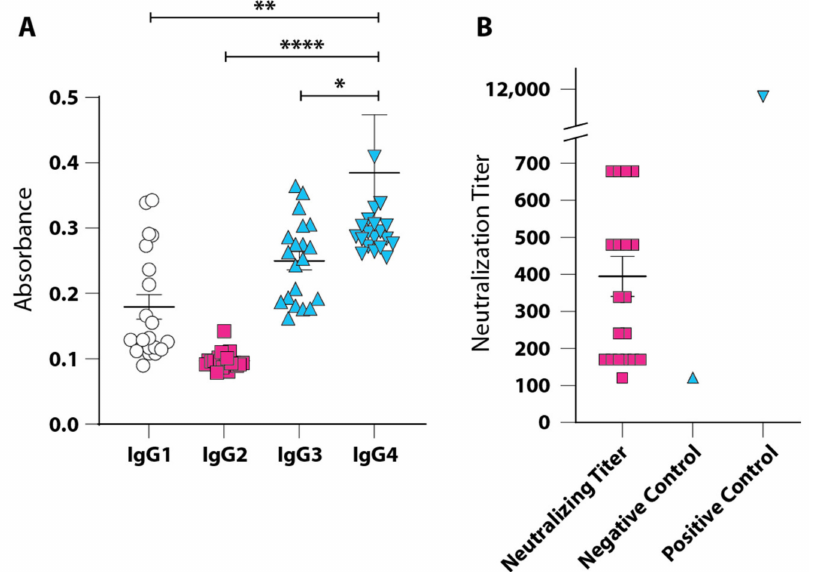
Figure 2. IgG isotypes in serum from unvaccinated, convalescent COVID-19 patients. ( A ) Evaluation of the sera for IgG isotypes of RBD-directed antibodies in 20 convalescent patients. Data are presented as ELISA absorbance values due to limited sample volume. ( B ) Neutralization titers in the serum samples ranged from 170 to 960 (GMT = 328). Serum from a naïve donor who had not been vaccinated or infected served as the negative control and serum from a donor who had received two doses of the Pfizer/BioNTech vaccine as the positive control. Statistical differences were calculated with one-way ANOVA with Fisher’s LSD: * p <0.05; ** p < 0.01; **** p <